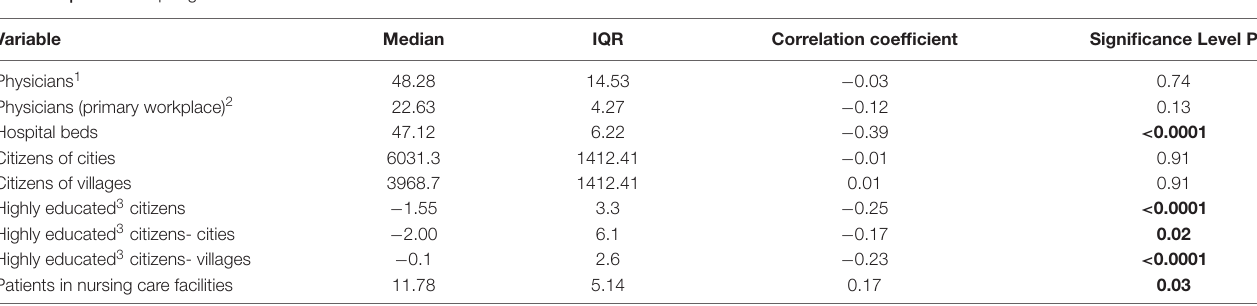
FIGURE 5 | (A) The median number of gastrostomies per 10,000 citizens in Poland from 2010 to 2020. (B) Voivodeships characteristics. Population data from 2019 (according to the Polish Department of Statistics). Hospital beds and patients in nursing care facilities—median (from 2010 to 2020) per 10,000 citizens. Education (calculated as the difference between the percentage of the population with higher education by voivodeship and the national average). TABLE 4 | Voivodeship regional